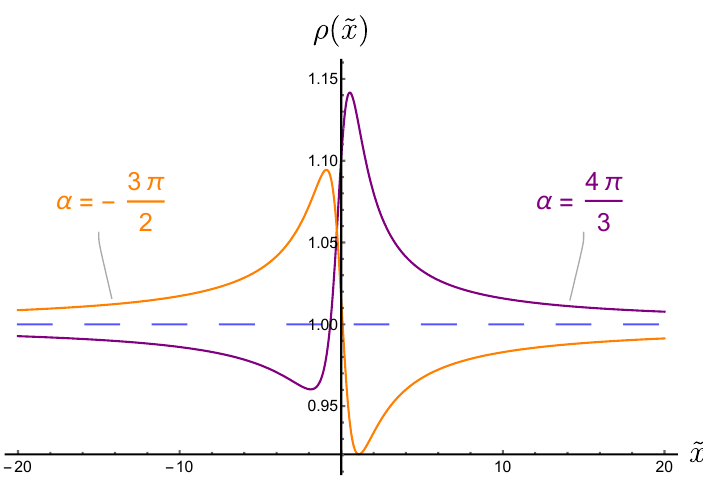
Figure 20 . The dS version of the Breit-Wigner distribution associated to a resonance. Here we (cid:0) d (cid:1) set the positive quantity ρ free ( ν σ ) to 1, α = π − 2 iν φ and ˜ x = x/γ is the ratio between x , the 2 displacement from the resonance ν = ν σ in units of the coupling g 2 , and the width γ . The two curves are for ν σ = 1 and α = 4 π (purple)/ α = − 3 π (orange). For large positive and negative ˜ x , ρ 3 2 approaches the free value ρ free ( ν σ ) , indicated by the dashed blue line. The curve has two extrema at the positions